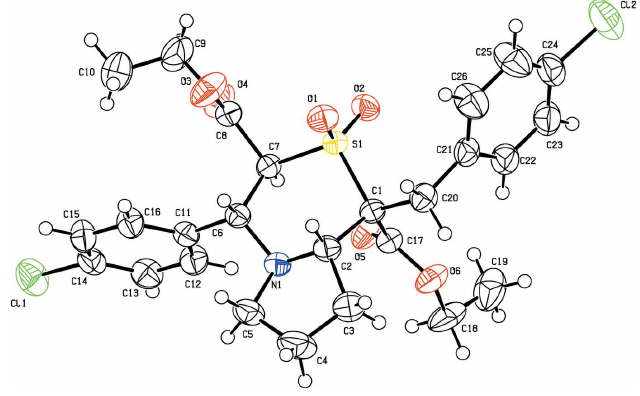
Figure 1 Displacement ellipsoid plot (50% probability level) of title compound (I), showing the atom-labelling